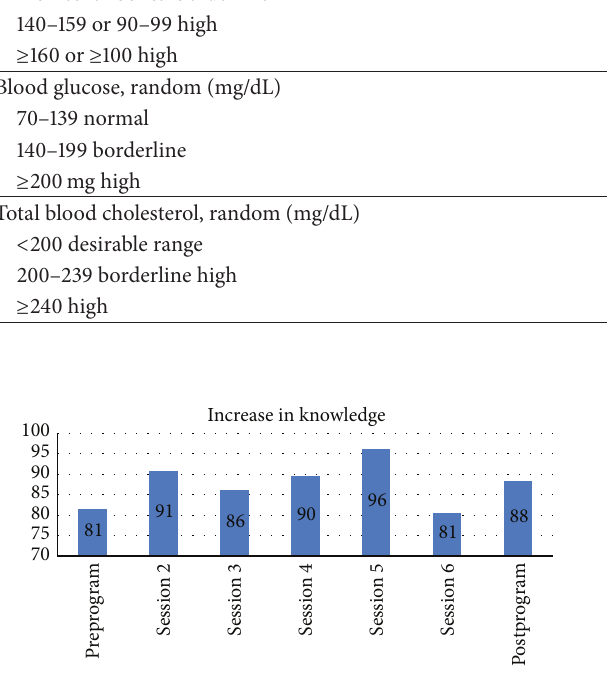
Figure 3: Postintervention knowledge